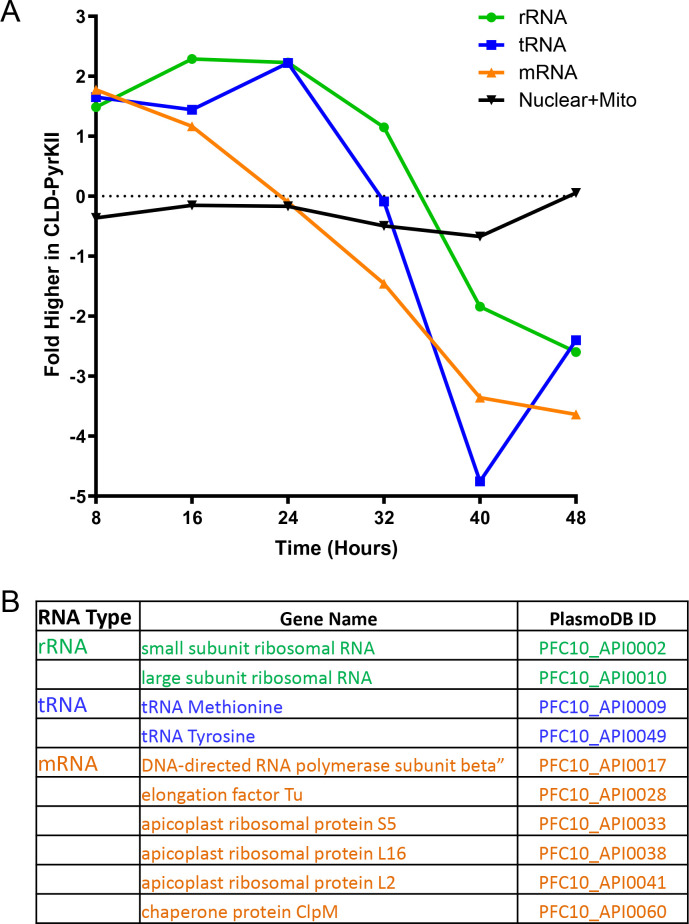
Analysis of apicoplast RNA levels in PfMev CLD-PyrKII parasites after treatment with Shield1.(A) The microarray data shown in Figure 6C are plotted showing the averages of each RNA type, indicating that mRNAs (orange) seem to decrease in abundance prior to tRNA (blue) and rRNA (green) species. (B) The apicoplast RNAs studied in the microarray analysis are listed with their PlasmoDB identification numbers.